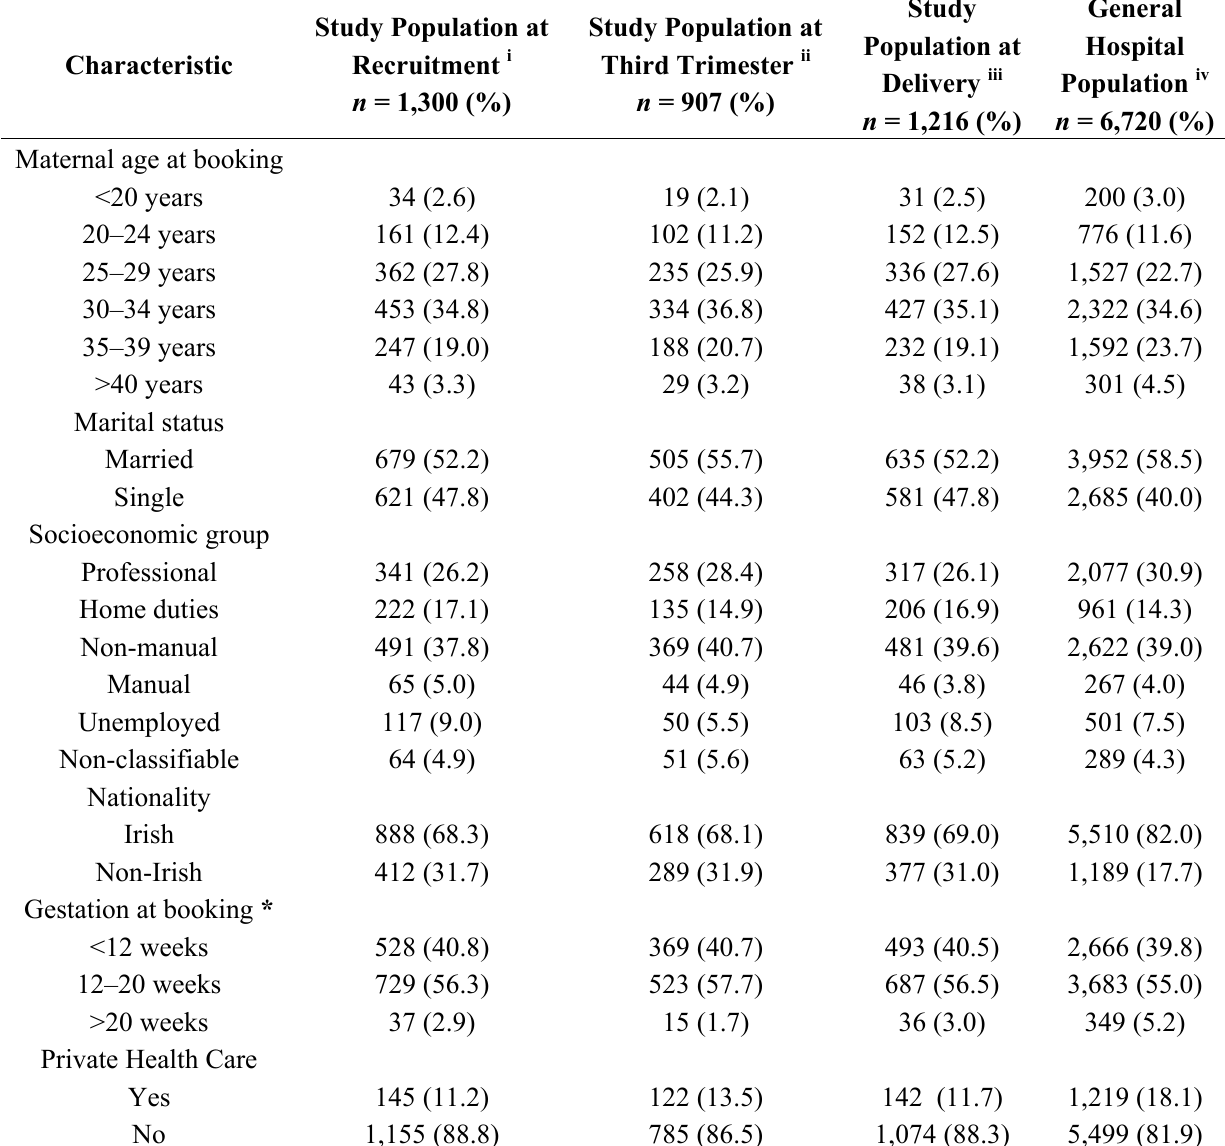
Table 1. Characteristics of Study Cohort in relation to the hospital